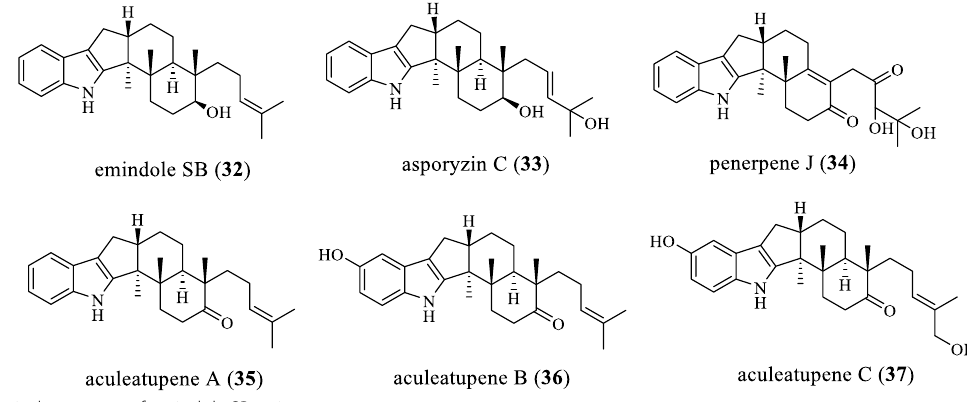
Fig. 2 Chemical structures of emindole SB series